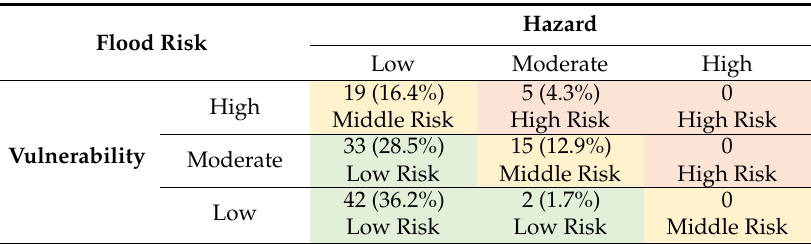
Table 5. Flood risk matrix.